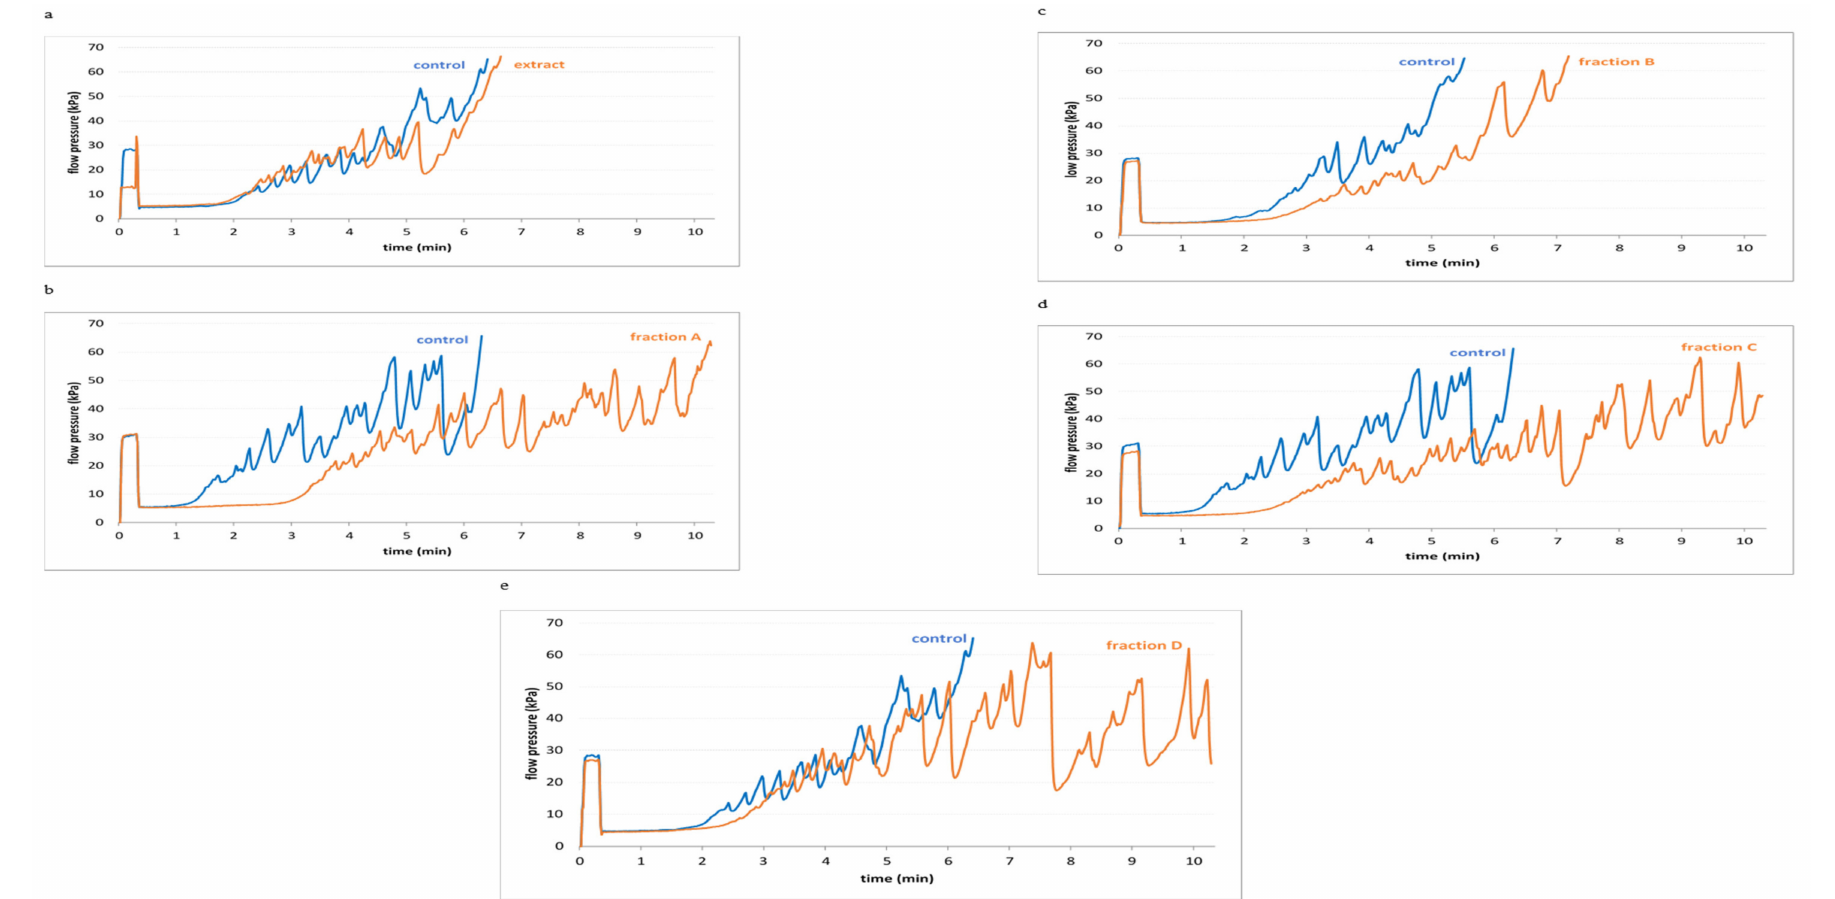
Figure 4. Selected diagrams for T-TAS analysis for extract ( a ) and four fractions (A–D) ( b – e ) from Paulownia Clon In Vitro 112 ® leaves (50 µ g/mL; 30